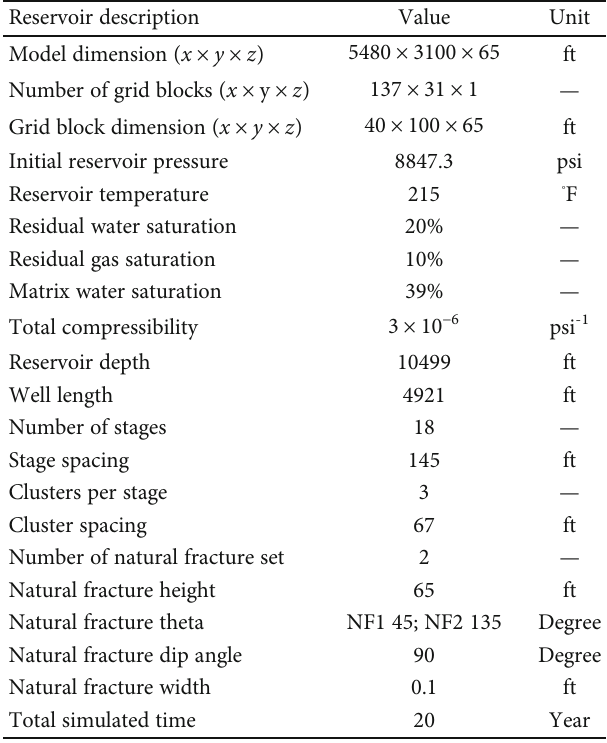
Table 1: Summary of reservoir and fracture properties used in this